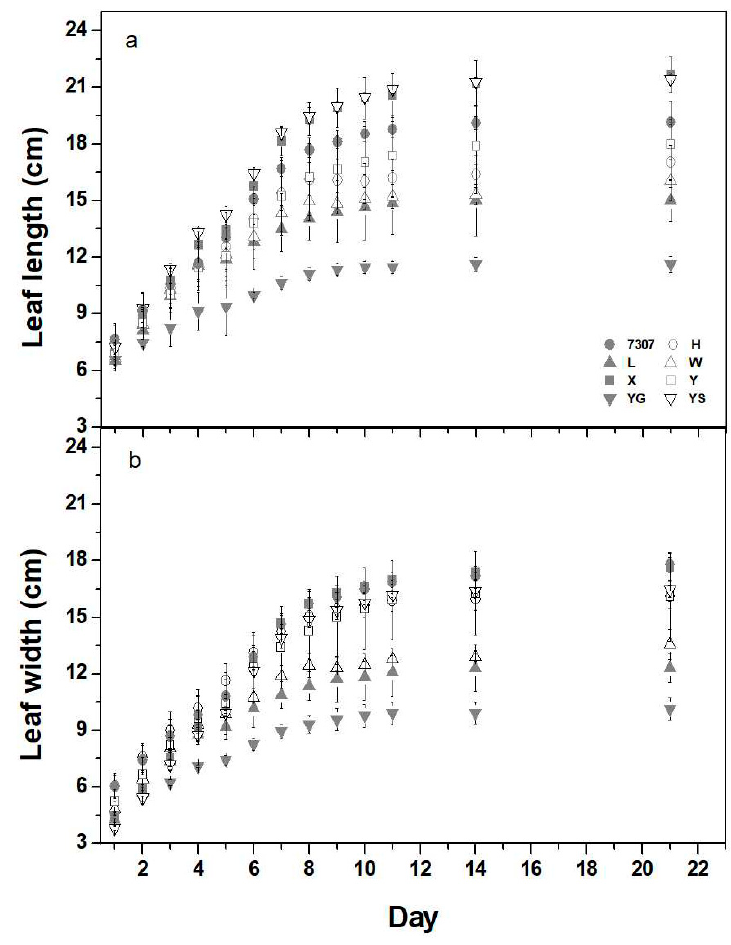
Figure 2. Leaf expansion in eight 3-year-old mulberry cultivars: 7307, Husang32 (H), Liaolu11 (L), Wupu (W), Xiang7920 (X), Yu711 (Y), Yunguo1 (YG), and Yunsang2 (YS). Measures were performed